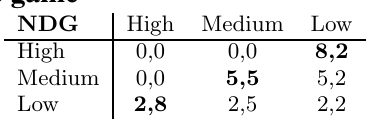
Table 1: Nash Demand Game payoff